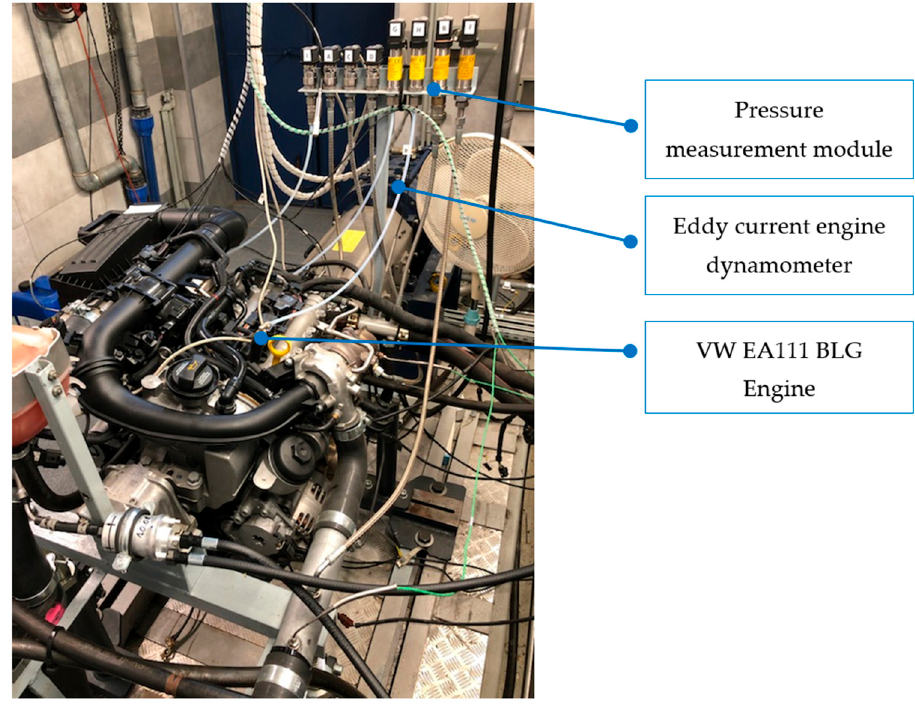
Figure 1. General view of test stand with VW EA111 BLG engine (photo INIG–PIB).